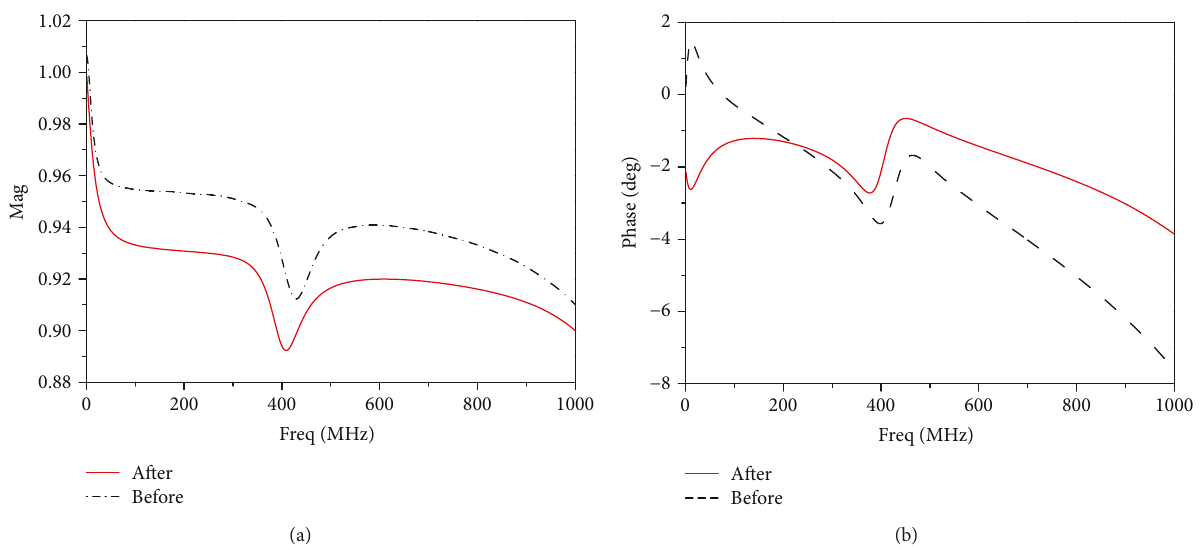
Figure 5: Loop gain of the NIC with dipole terminated before and after adding the stabilization network: (a) magnitude of the loop gain; (b) phase of the loop gain.